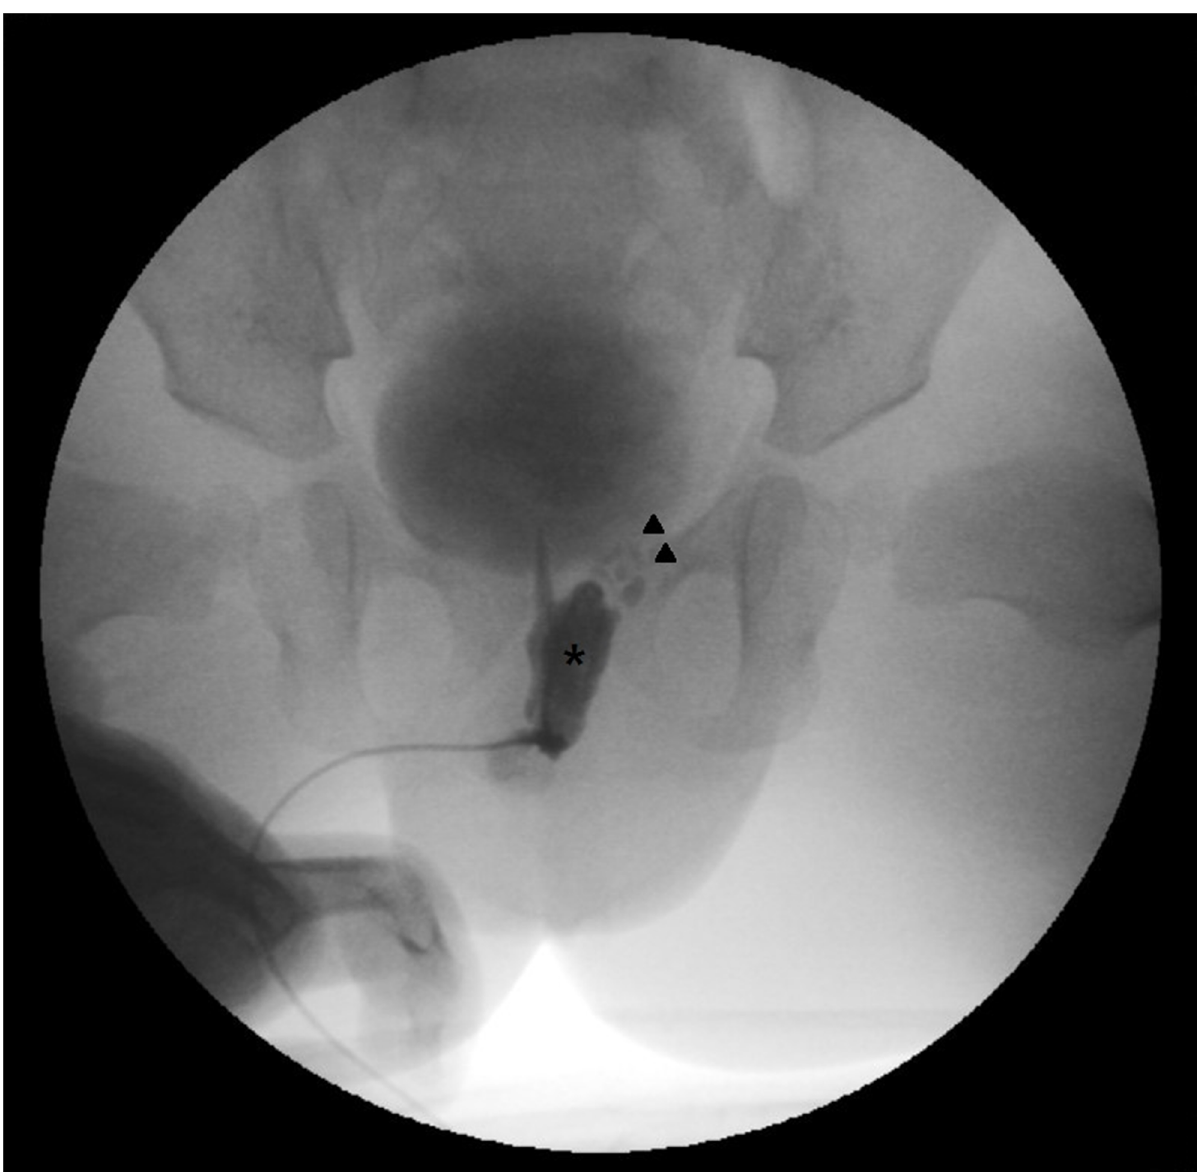
Fig 3. Cystic dilated prostatic utricle found in 11 month old boy after 3 rd episodes of left acute epididymitis. Left ejaculatory duct was inserted not into the urethra, but into the prostatic utricle. Left vasectomy was performed in this patient. (cid:3) Arrow head: left ejaculatory duct, Asterisk: cystic dilated prostatic